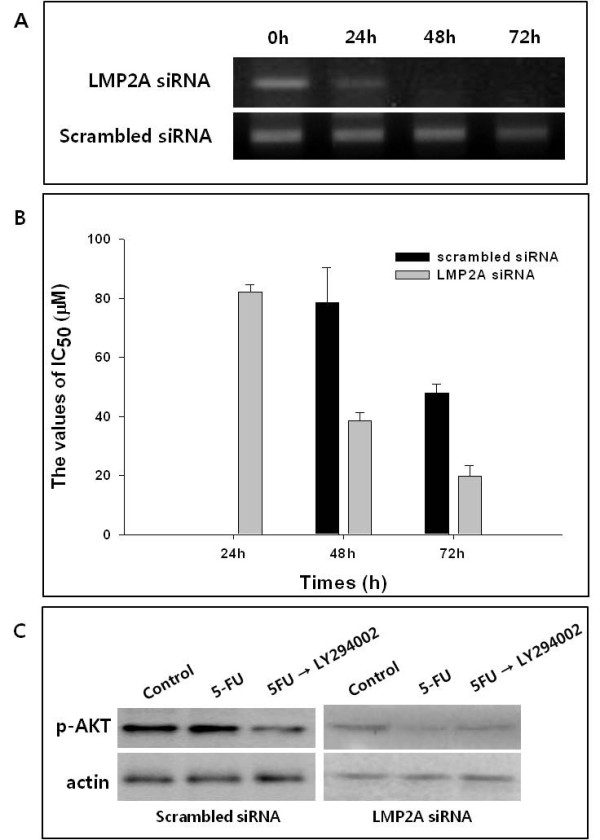
Cytotoxic effects of 5-FU and the expression of p-AKT by drug treatment in cells transfected with LMP2A siRNA. (A) LMP2A siRNA-silenced SNU-719 cells were subjected to RT-PCR for LMP2A in a time-dependent manner. (B) The inhibitory effects on cellular proliferation caused by 5-FU treatment were more pronounced in SNU-719 cells transfected with LMP2A siRNA than in cells transfected with the scrambled siRNA. (C) The expression of p-AKT was reduced further by 5-FU in cells transfected with LMP2A siRNA compared with in cells transfected with the scrambled siRNA (NC).